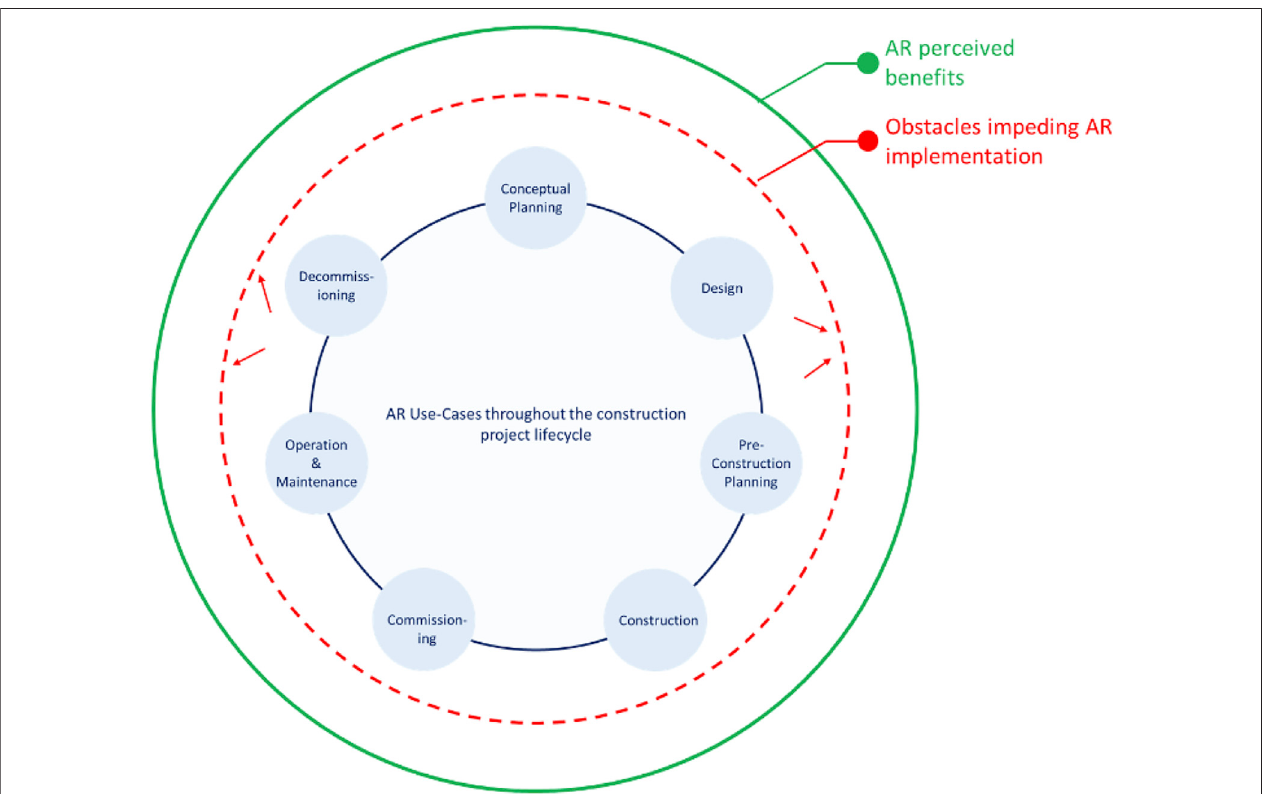
FIGURE 8 | Research scope of